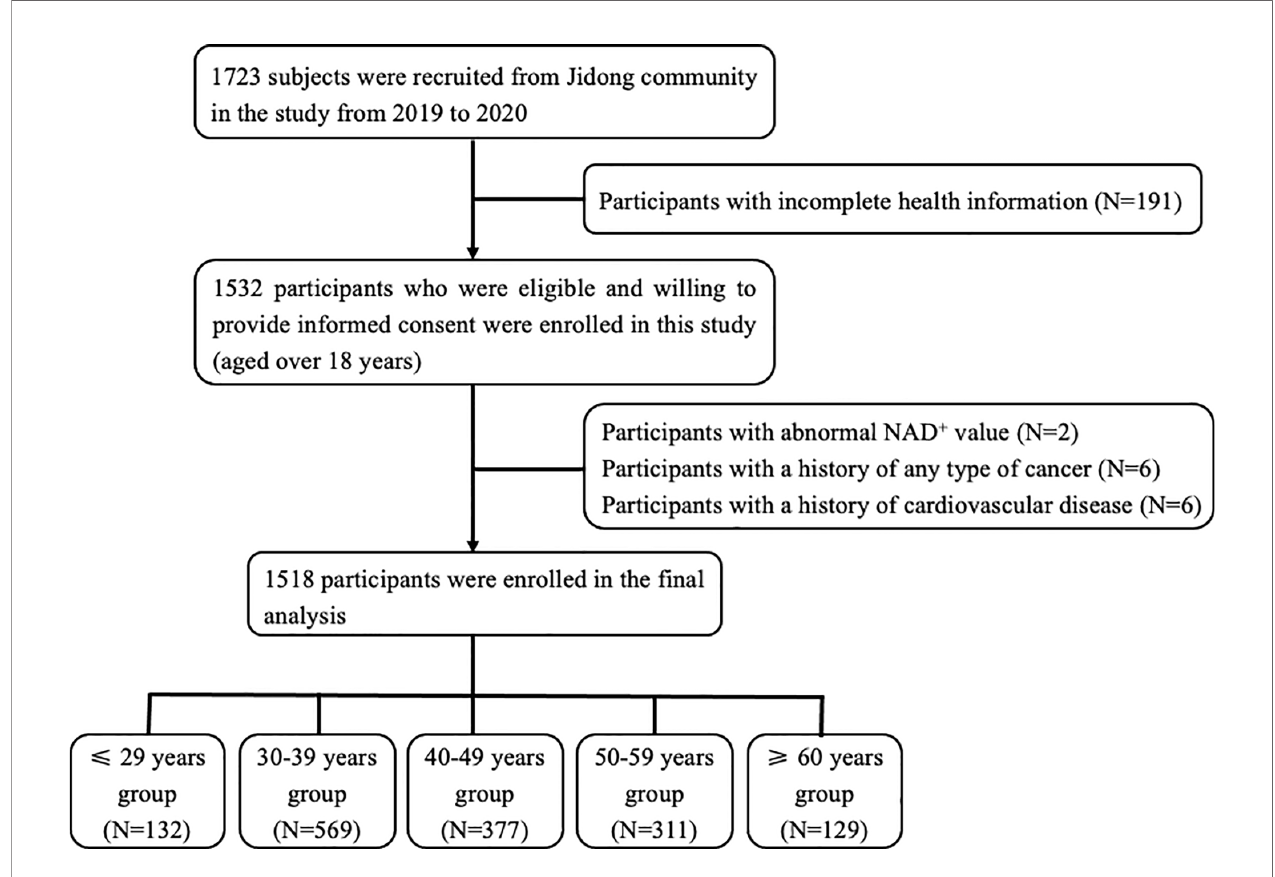
FIGURE 1 | Flow chart of the enrolled